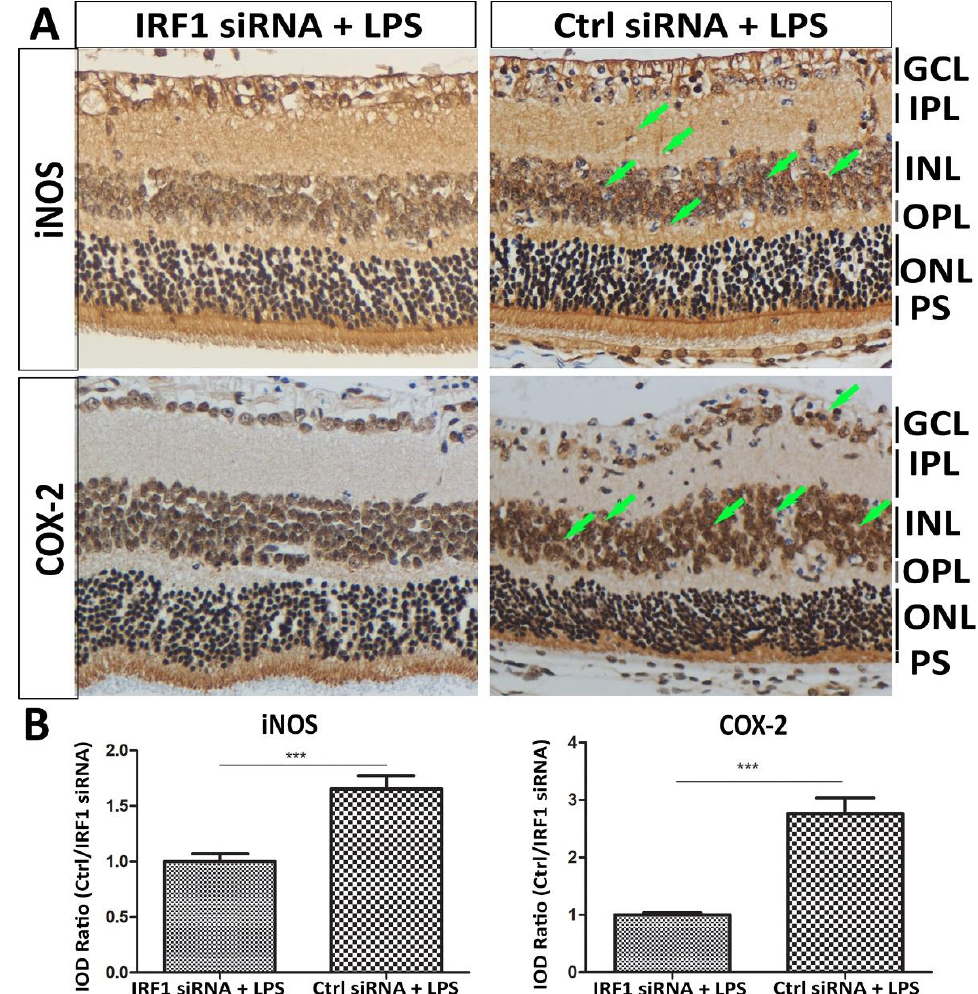
Figure 8. IRF1 knockdown suppresses retinal inflammation induced by LPS in mice. The mice were treated with IRF1-siRNA + LPS and Ctrl siRNA + LPS via intravitreal injection. DAB-IHC staining showed the protein expression levels of inflammatory markers iNOS and COX2. The staining signal intensity indicates the protein expression level (arrows), which was higher in the Müller cellular processes and the inner nuclear layer of the Ctrl siRNA + LPS than the IRF1-siRNA + LPS. ( A ) The representative images are shown. Hematoxylin stained the nuclei. ( B ) The quantification results of IHC staining signals were determined by Image J software-IHC Image Analysis Toolbox. The results are expressed as the integrated optical density (IOD) ratio of Ctrl siRNA + LPS vs. IRF1-siRNA +